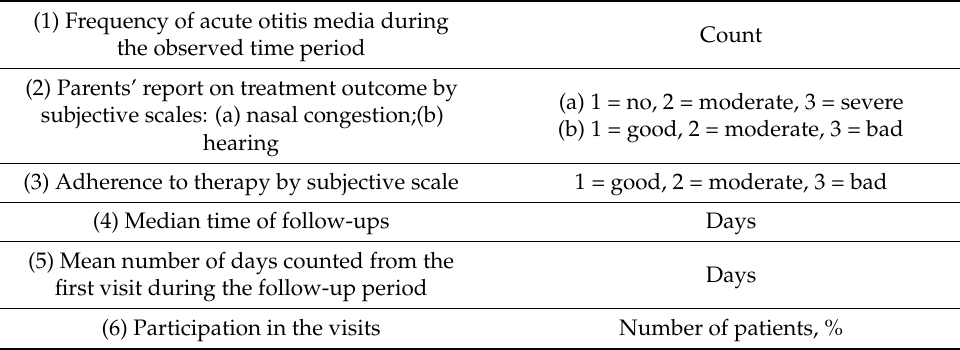
Table 2. Secondary outcome